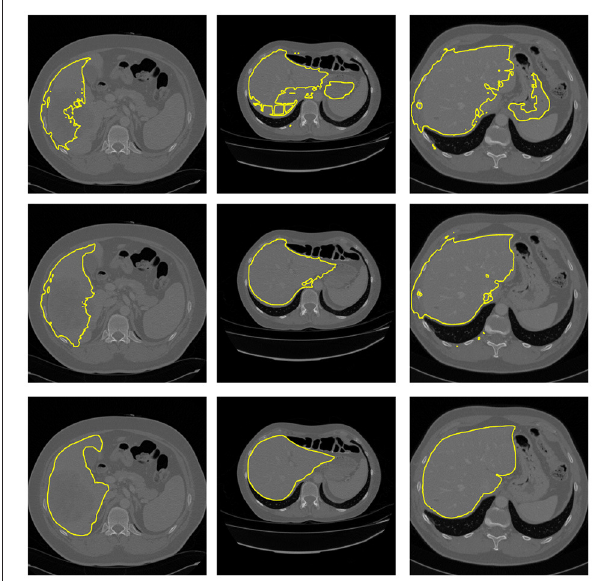
FIGURE 5 | Example of segmentation results from 3D U-Net. Top : Segmentation without body-navigation features. Middle : Segmentation with body-navigation features. Bottom : True mask.